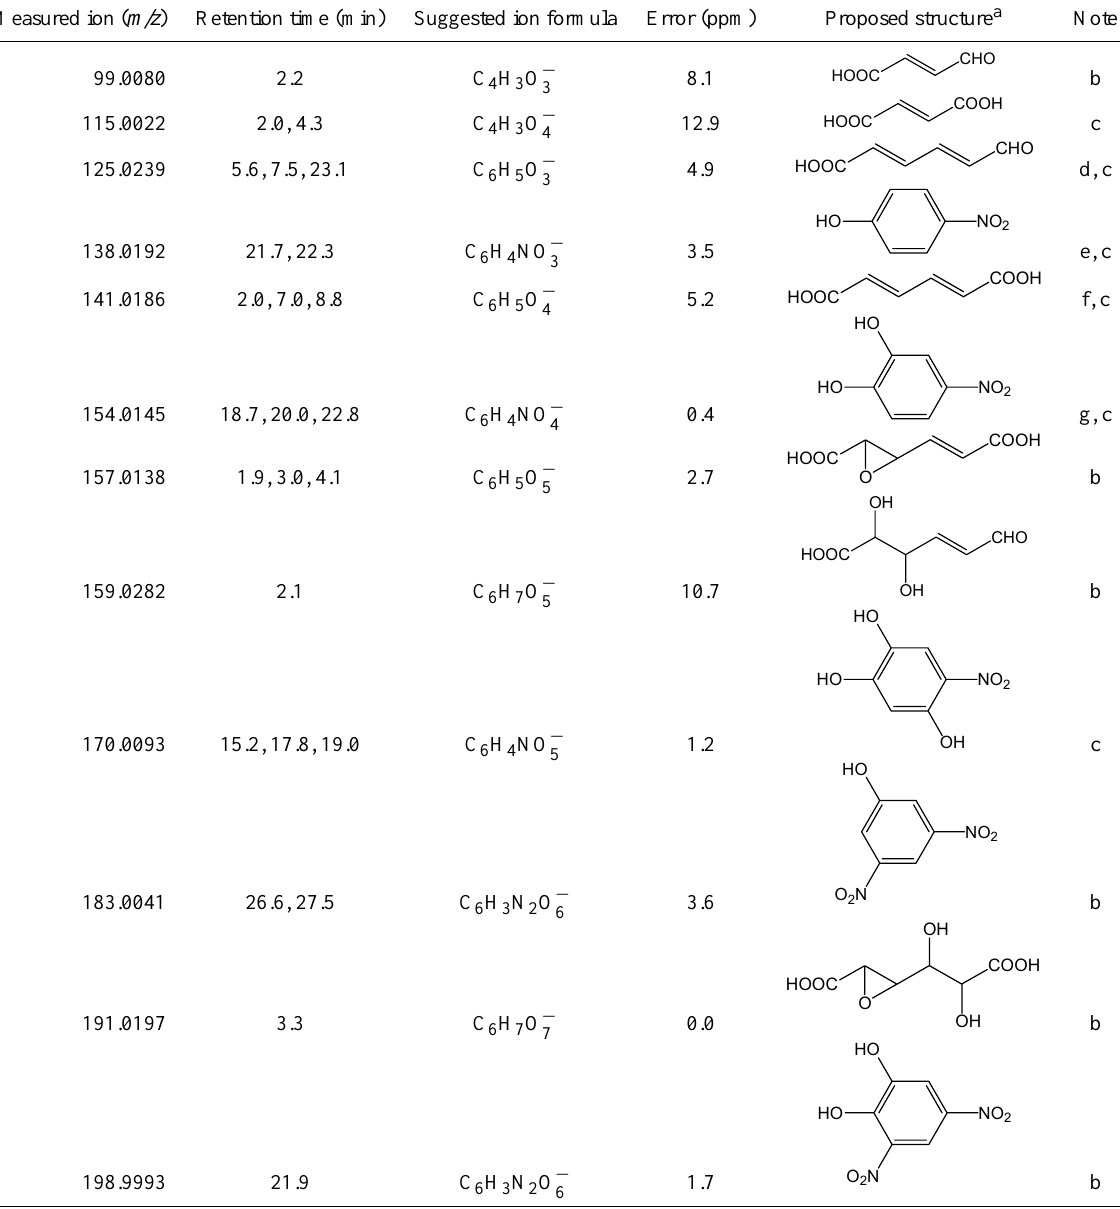
Measured ion ( m/z ) Retention time (min) Suggested ion formula Error (ppm) Proposed structure a